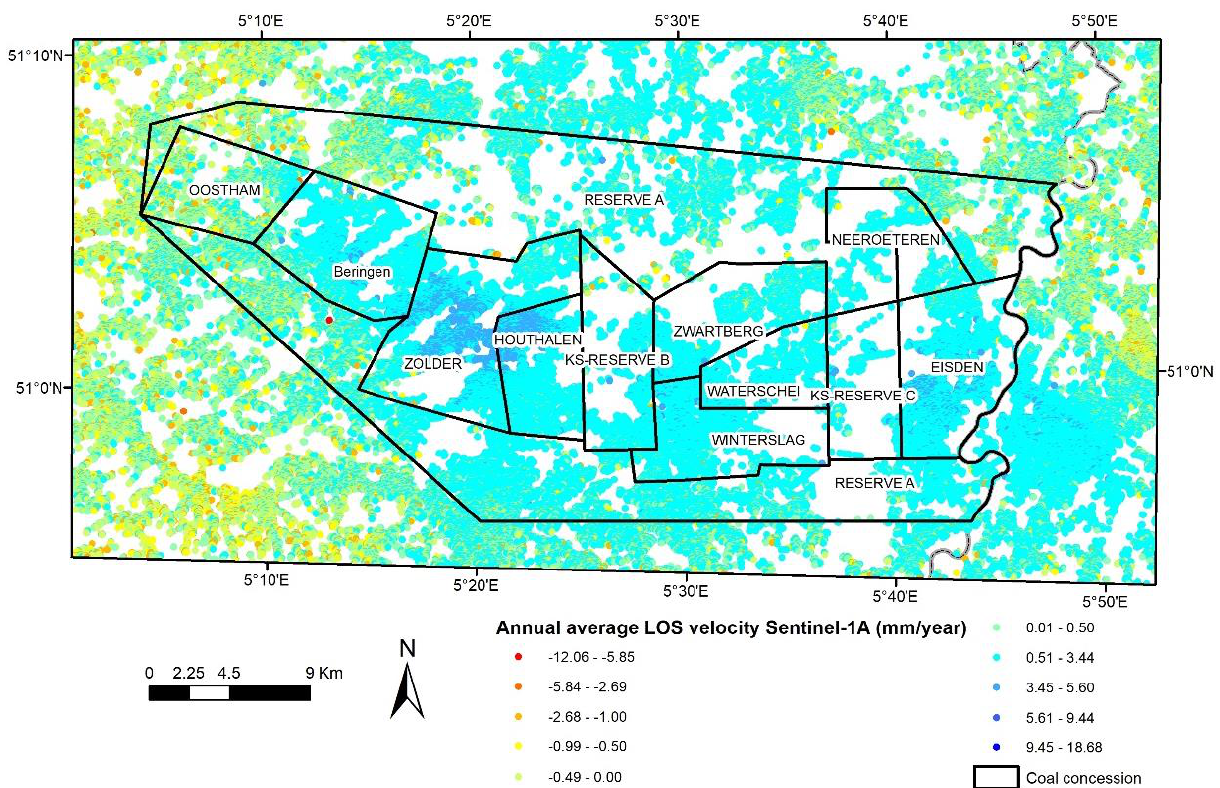
Figure 7. Color classification based on the average annual LOS velocities of PS points for Sentinel-1A (2016–2022) and extension of the coal concessions in Limburg.